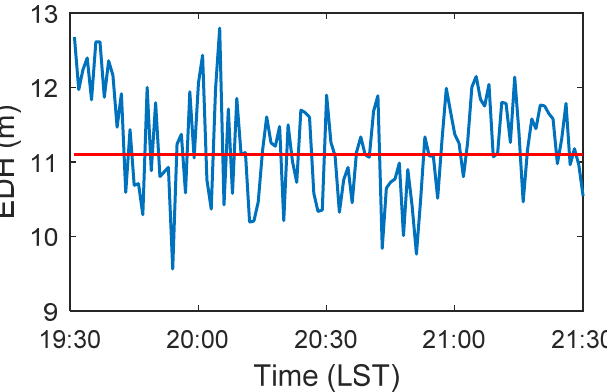
Figure 4. Short-term variation of the EDH (red line indicates the average EDH). Figure 4 shows that the average EDH is ~11 m (red line). The minimum and maximum EDH are ~9.5 and ~13 m, respectively, and the variation range is ~3.5 m. The short-term variation of the EDH is mainly caused by the change of hydrometeorological parame- ters, systematic error of the sensor, and measurement error. Due to the non-stationary characteristics of the EDH, it is difficult to nowcast the